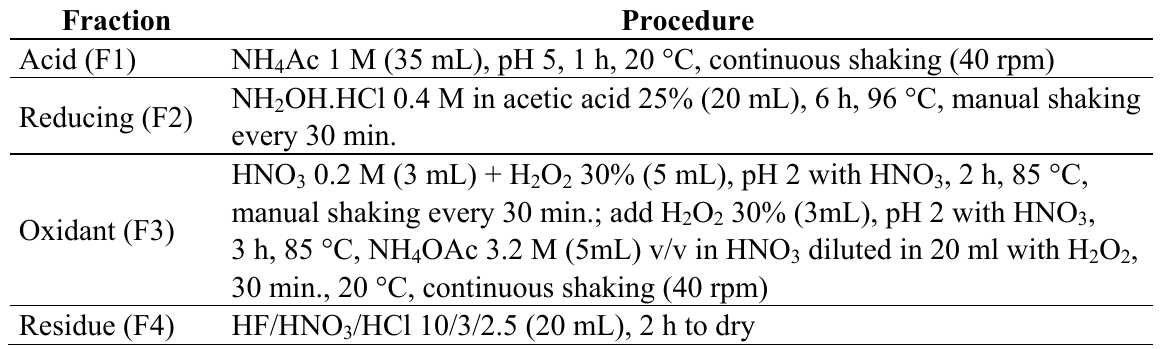
Table 4. Sequential extraction scheme for assessment of partitioning of metals in sediments given by Tessier et al. [17] and modified by Galán et al .